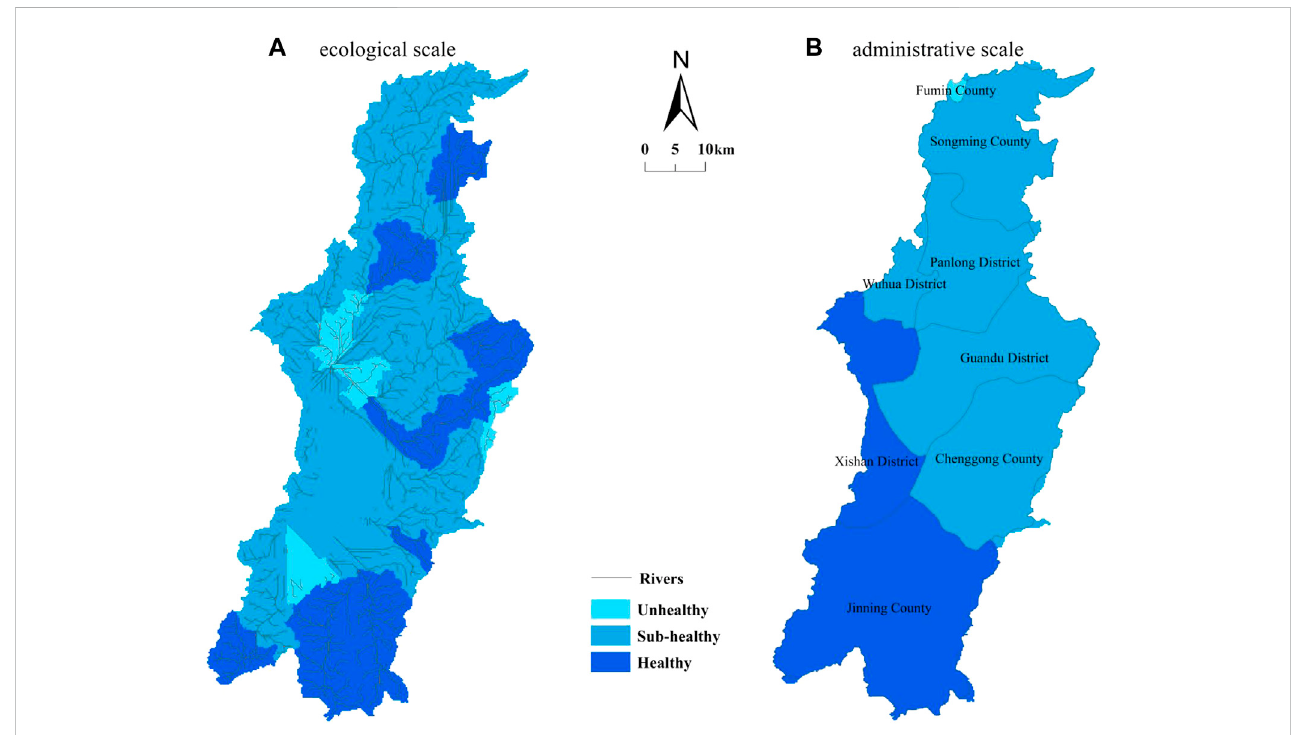
FIGURE 4 Ecosystem health in Dianchi Lake basin at ecological scale and administrative scale.